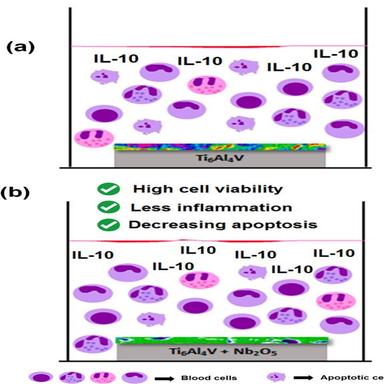
Schematic drawing for biological assays. (a) Ti6Al4V alloy and (b) Ti6Al4V alloy containing Nb2O5 thin film.